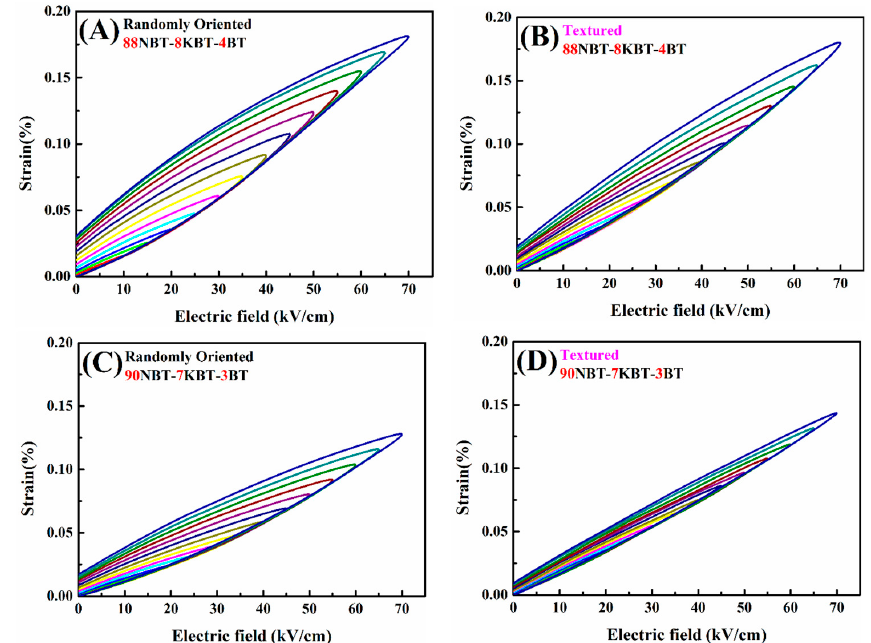
Figure 5. Strain curves for ( A ) randomly oriented 88NBT ceramic, ( B ) textured 88NBT ceramic, ( C ) randomly oriented 90NBT ceramic, and ( D ) textured 90NBT ceramic.